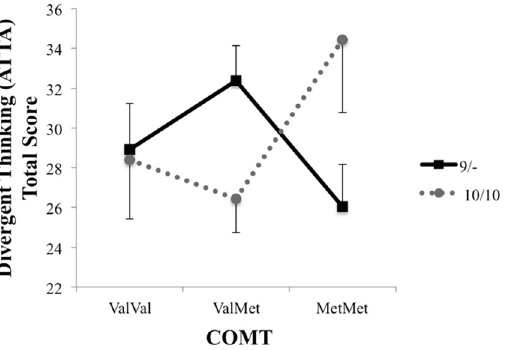
Fig 3. Estimated marginal means for ATTA total scores, controlling for academic achievement.